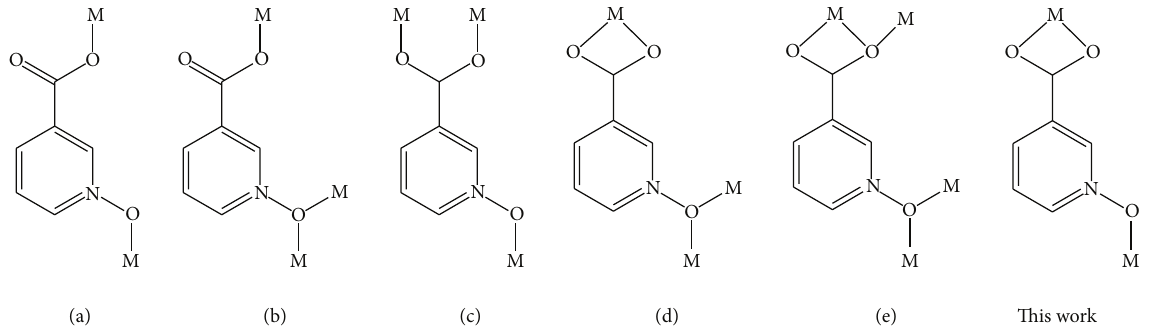
Scheme 1: Coordination modes of the nicotinate N -oxide (NNO − ) ligand.